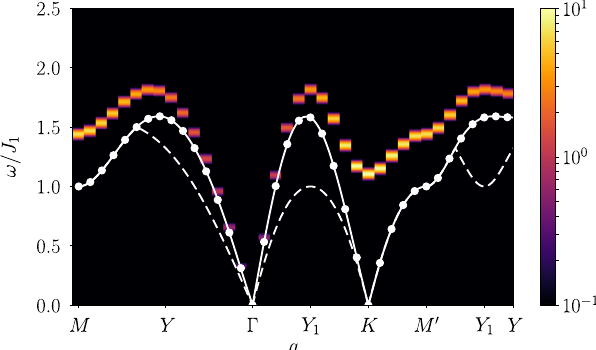
FIG. 2. Dynamical structure factor of the nearest-neighbor Heisenberg model on the triangular lattice obtained by using the variational wave function of Eqs. (12) and (13) with t ¼ 0 on the 30 × 30 cluster. The path along the Brillouin zone is shown in Fig. 1. A Gaussian broadening of the spectrum has been applied ( σ ¼ 0 . 02 J 1 ). The spin-wave energies of the magnon branch ( ϵ q ), on the same cluster size, are represented by the white dots connected with a solid line. The dashed line corresponds to the bottom of the continuum within linear spin waves, i.e., E q ¼ min k f ϵ q − k þ ϵ k g . Notice that E q < ϵ q in most of the Brillouin zone, as obtained in Refs.